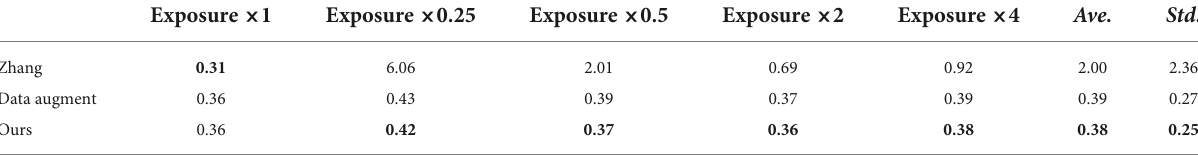
TABLE 5 Comparison of root-mean-square error (RMSE) (%) of different optimization methods under different tested exposure levels. Exposure × 1